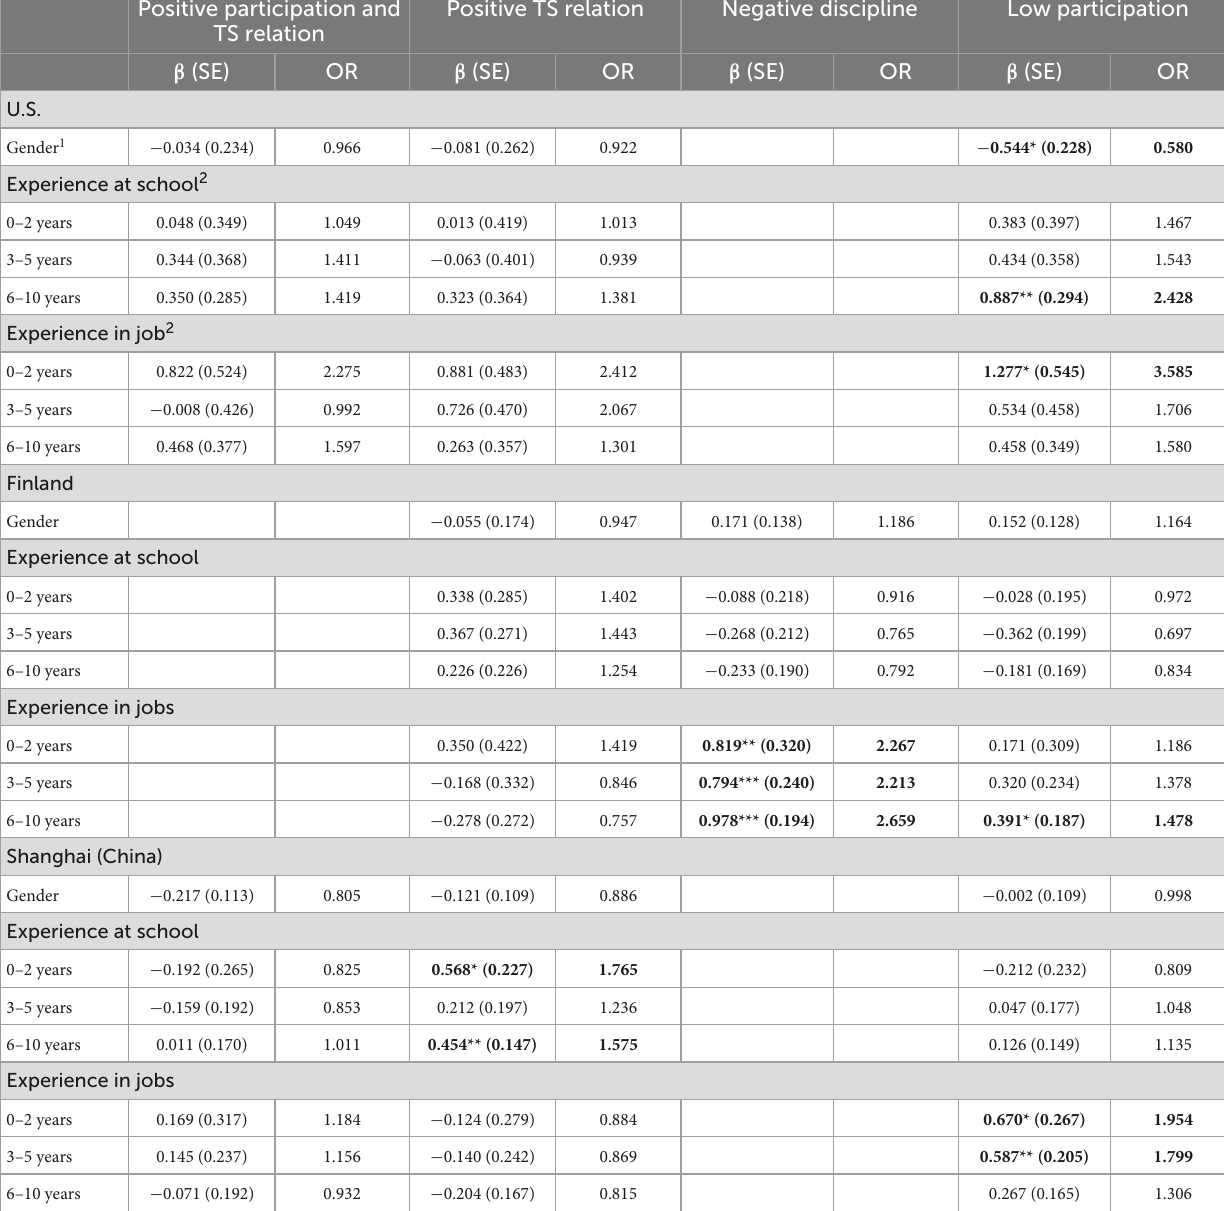
TABLE 7 Multinomial logistic regression results (compared to most positive